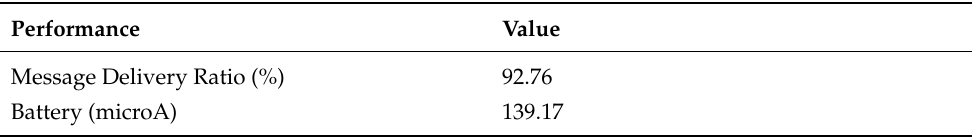
Table 3. Success of notification delivery and